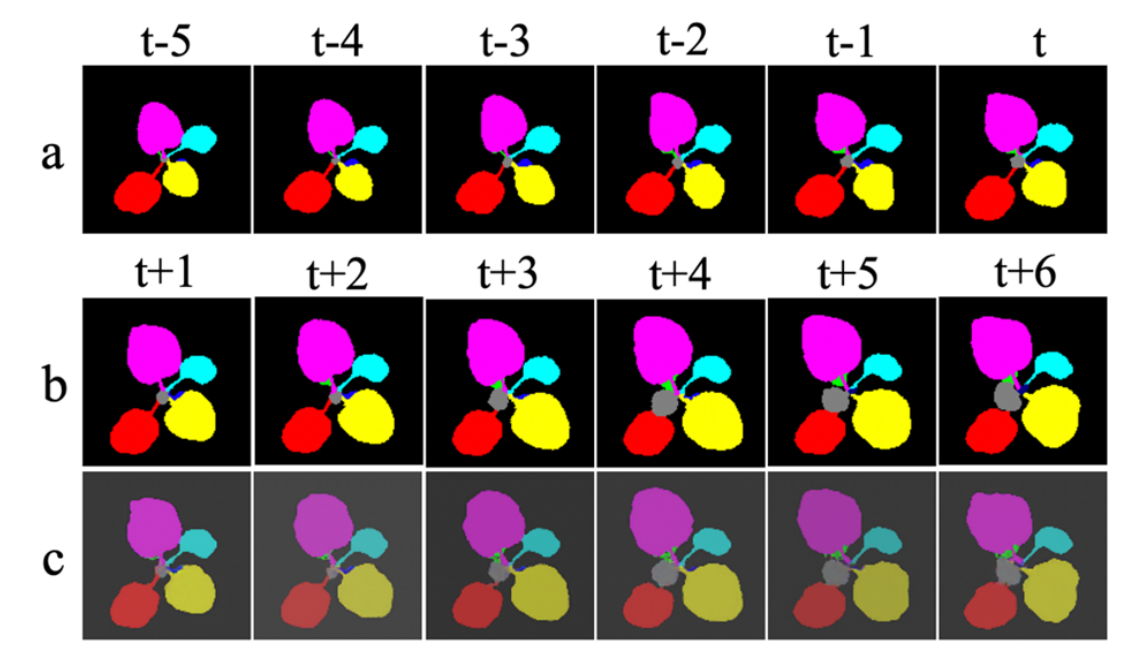
Figure 5. Samples of the results predicted by our proposed GAN architecture on Komatsuna plant leaf dataset. ( a ) Input frames. ( b ) Ground truth. ( c ) Predicted